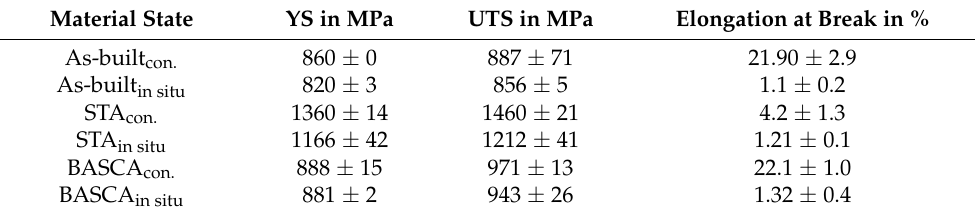
Table 2. Comparison of conventional and in situ tensile test results of EB-PBF Ti-5553 using E L = 600